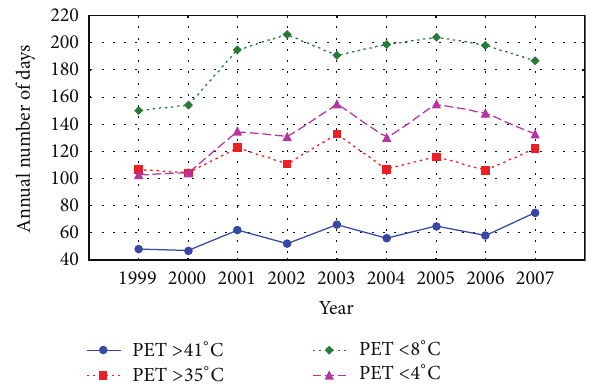
Figure 6: Annual number of days with PET > 41 ∘ C, PET > 35 ∘ C, PET < 8 ∘ C, and PET < 4 ∘